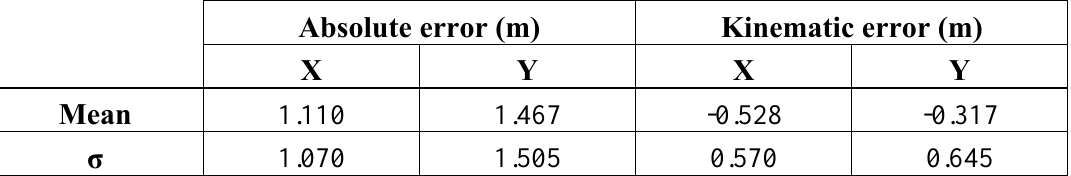
Table 1. Absolute and kinematic error of the GSM-19 GPS antenna instrument.